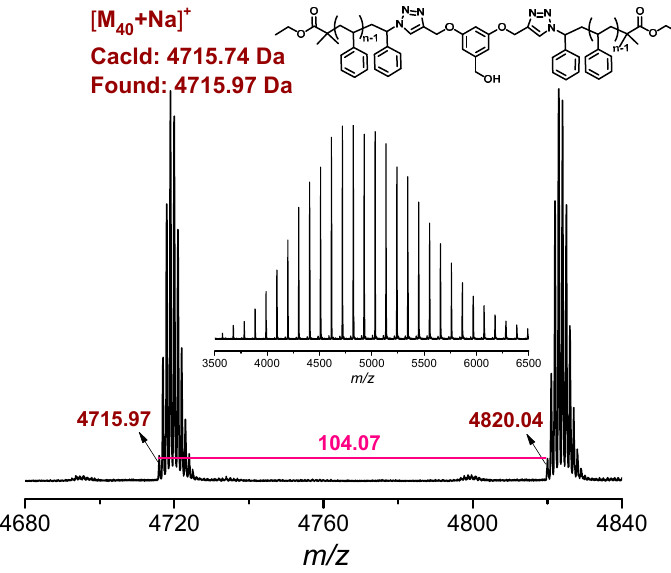
Figure 3. Expanded matrix assisted laser desorption ionization/time of flight mass spectra (MALDI-TOF MS) of l -PS-PhOH with the inserted full spectrum.